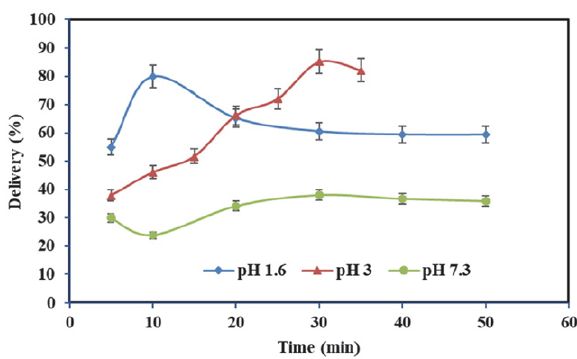
Figure 9. Metformin desorption (delivery) from the loaded Fe 3 O 4 @ SiO 2 @TG NPs in pH 1.6, 3.0 and 7.3. Number of replicates: